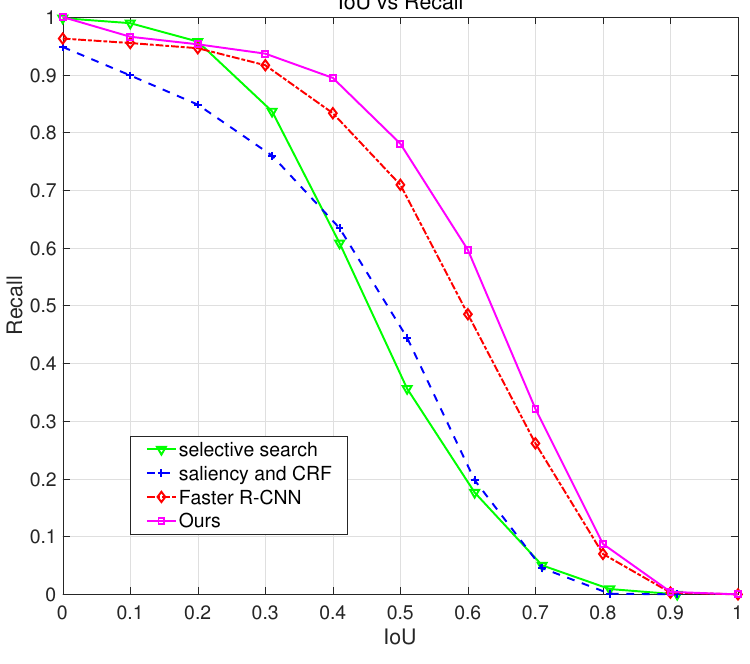
Figure 8. Comparison of the different detection proposal